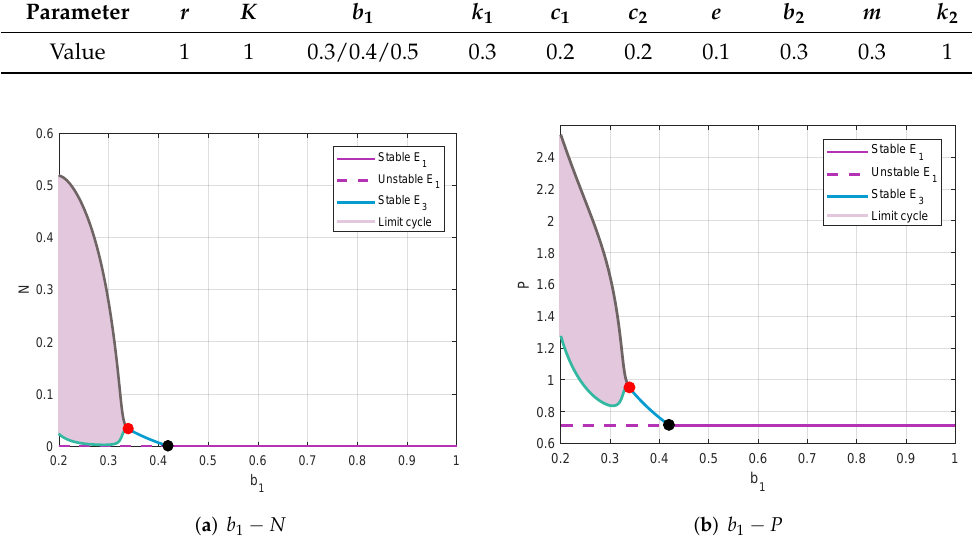
Figure 1. Bifurcation diagram of the system (3) with respect to the predation rate ( b 1 ) with parameter values as in Table 1: ( a ) N state and ( b ) P